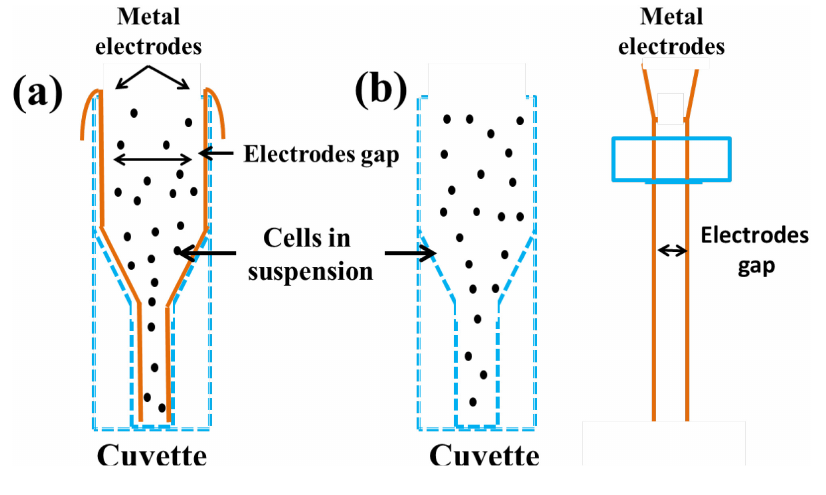
Figure 1. The bulk electroporation apparatus in vitro experiment with cross sectional view of two metal electrodes. The distance between two large electrodes varies from millimeter to centimeter range. To manufacture of this device is simple but the voltage requirement is very high to permeabilize of millions of cells together due to large distance between two electrodes (a) cells are in suspension within the cuvette, where two metal electrodes are fixed inside the cuvette for electroporation experiment (b) cells are suspension and metal electrodes can introduce from outside to inside of this cuvette. Figure has been redrawn from reference